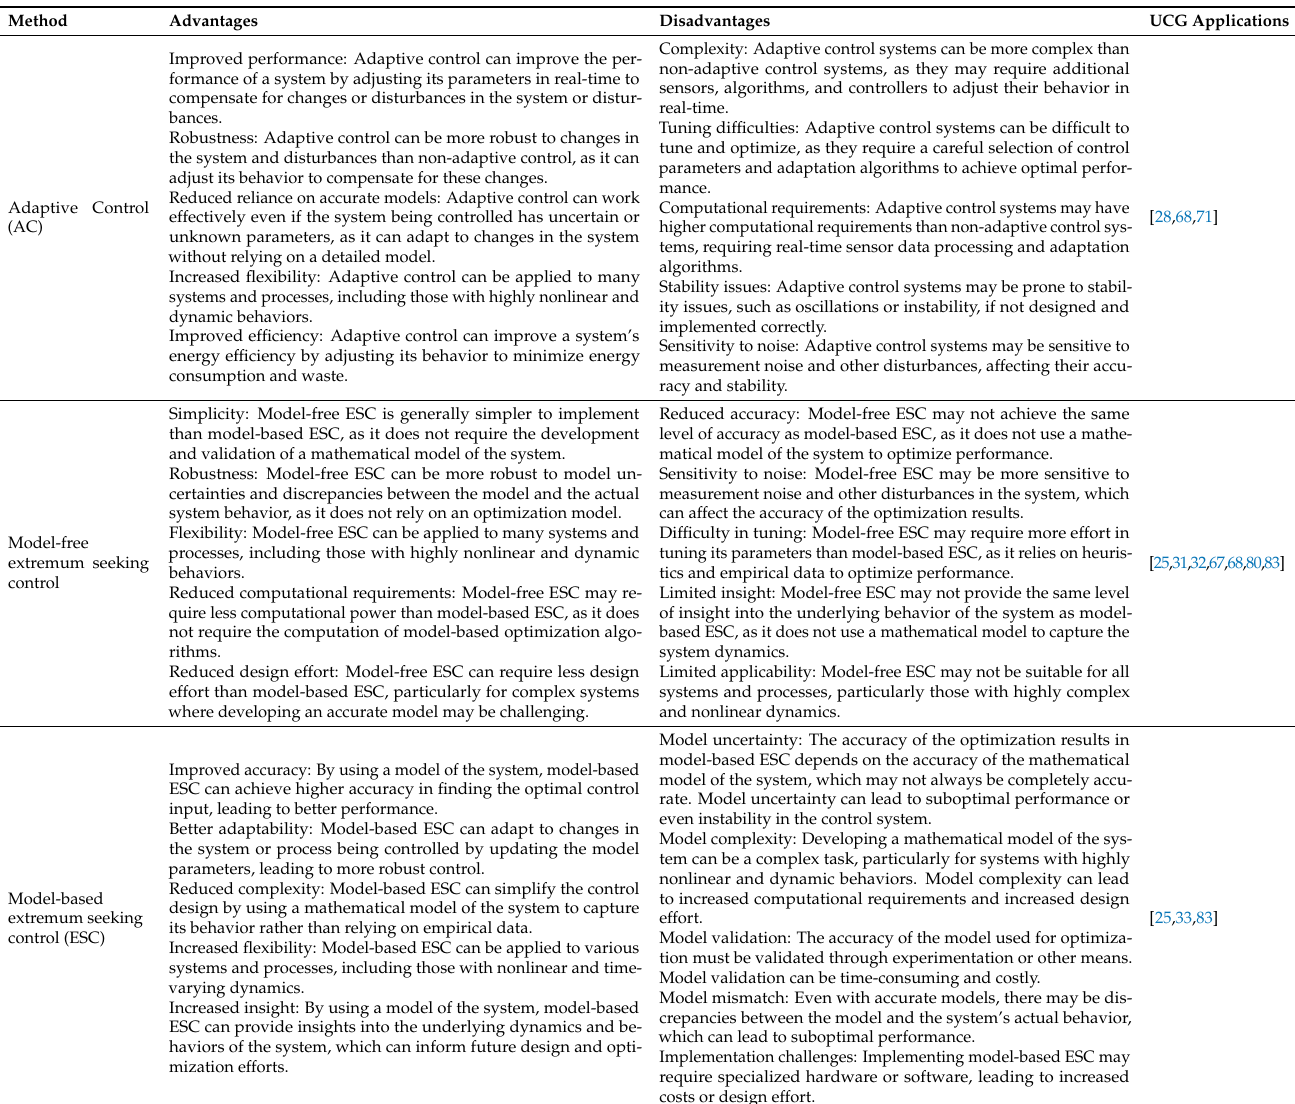
Table A1. Comparison of advantages and disadvantages of advanced control